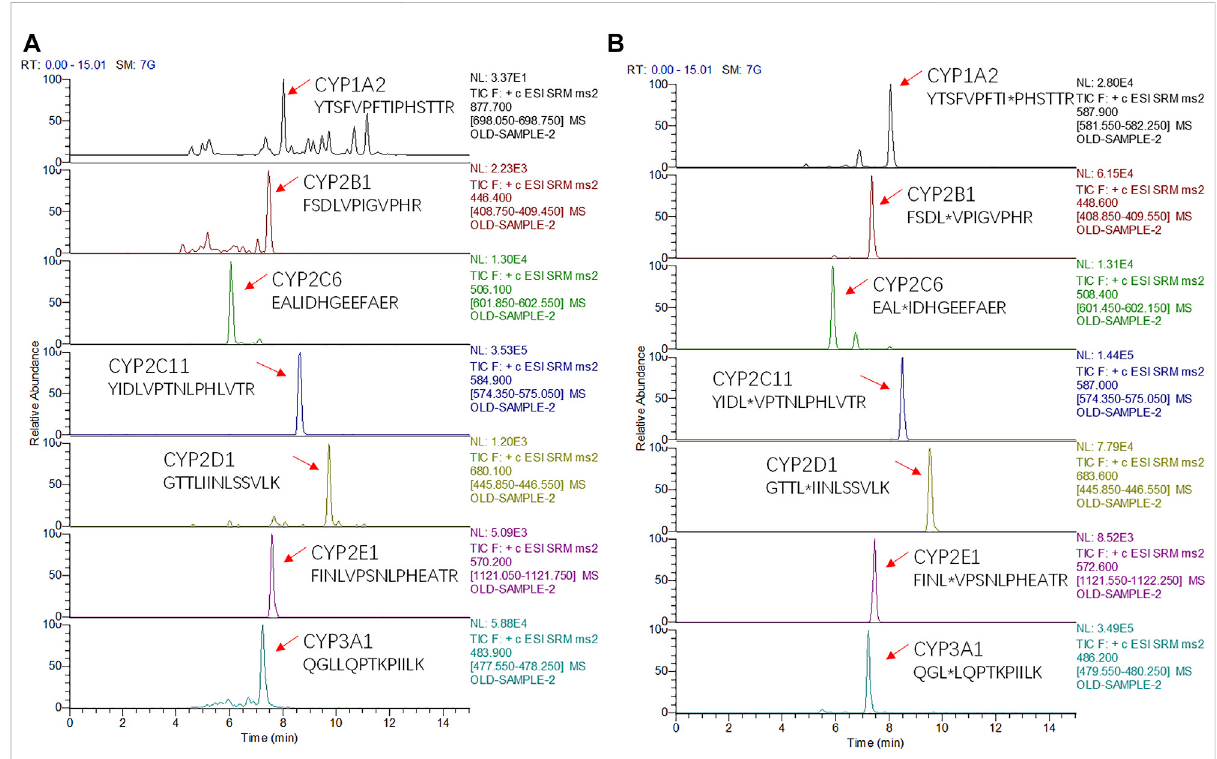
FIGURE 2 Peptide formation as a function of digestion time. Normalized calculations were performed with the response at the 6th hour as 100%. Six samples were measured in parallel at each time point.